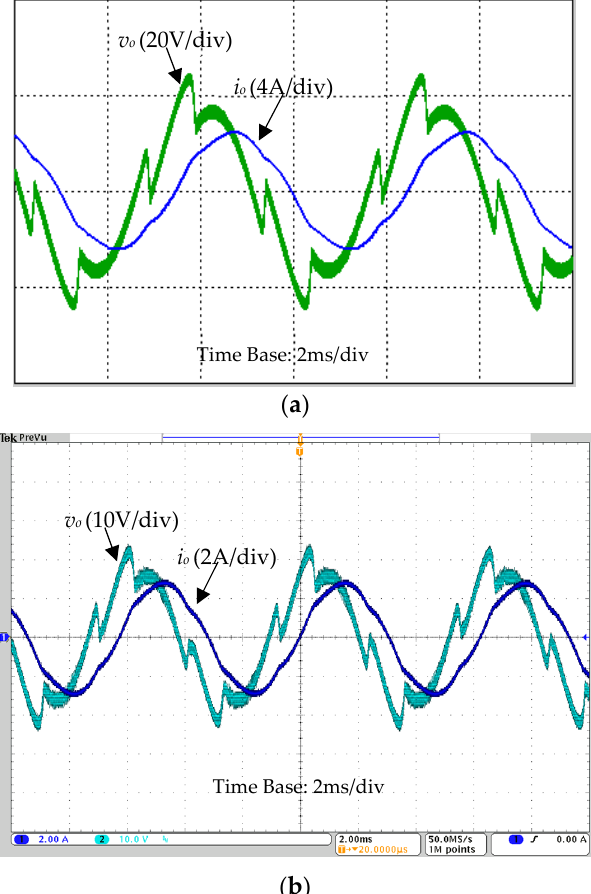
Figure 12. Output voltage and current of the hard ‐ switching inverter when the modulation index is 0.4 in an open ‐ loop configuration. ( a ) simulation results; ( b ) experimental results.